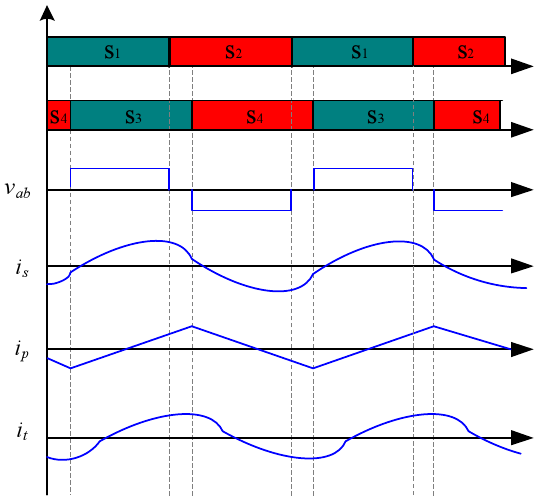
Figure 2. Steady-state operation waveforms of an LCL-type resonant